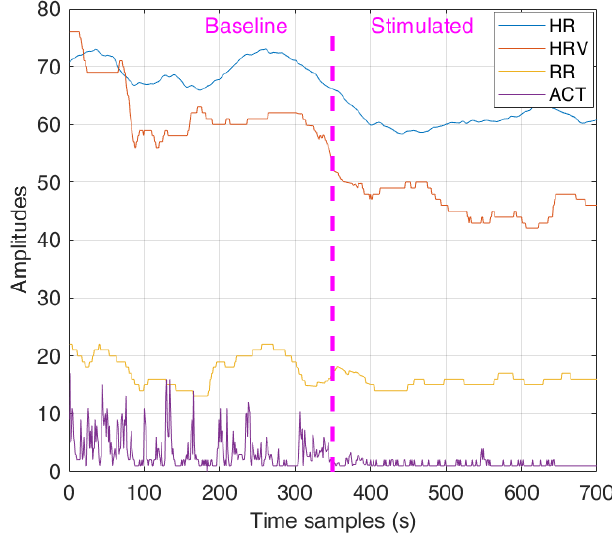
Figure 2. Physiological signals in baseline (AG) and stimulated (RE) behavioral states.